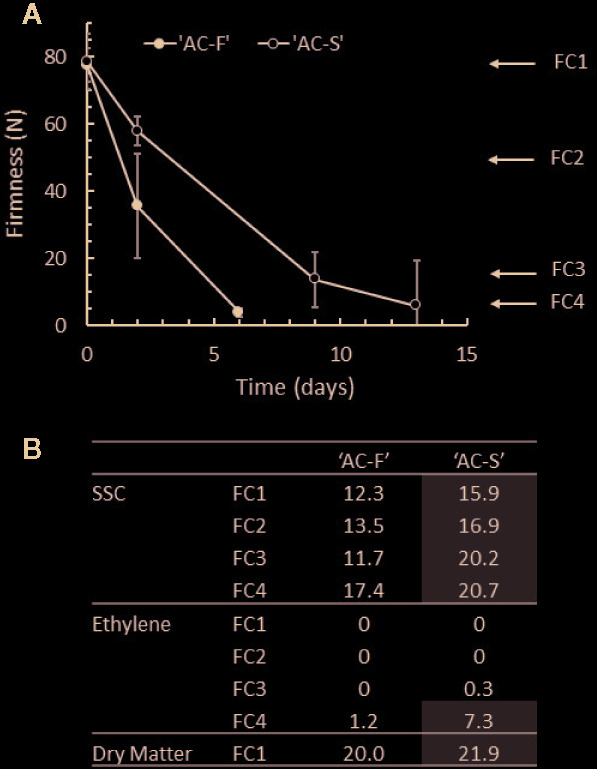
Ripening characteristics of Actinidia chinensis var. chinensis genotypes ‘AC-F’ (fast softening) and ‘AC-S’ (slow softening) during ripening at 20°C in ‘season 2’. (A) Change in the firmness of the outer pericarp of ‘AC-F’ and ‘AC-S’ during softening. (B) Soluble solid concentration (SSC) in °Brix, endogenous ethylene production in nmol ethylene·kg fruit−1·s−1 and dry matter in % throughout softening. Values are means ± standard deviation (n = 30) of ‘season 2’ fruit. The ripening characteristics of season 1 are summarized in 
Supplementary Table S4
.